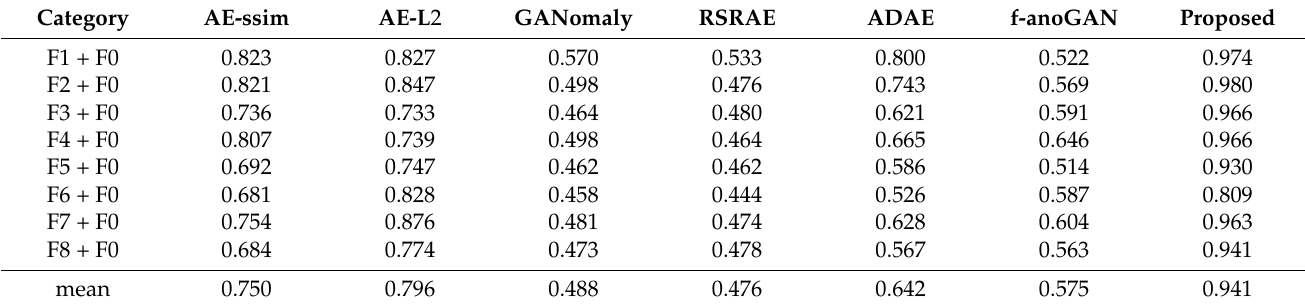
Table 6. Quantitative comparisons with other method (Average Precision,